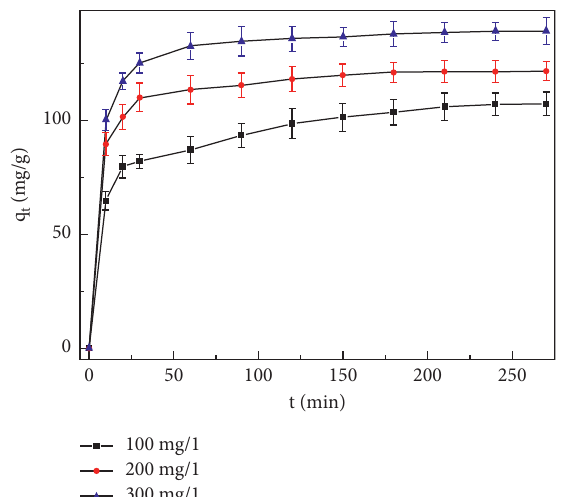
Figure 6: Effects of adsorption time on the adsorption of Cu(II) by PAC850-1-3 (PACs dose: 0.0500g; temperature: 30 ° C; pH: 5; volume of of Cu(II) solution: 200ml; concentration of Cu(II): 100, 200 and 300mg/l). Error bars indicated standard deviation of three replicated experiments.